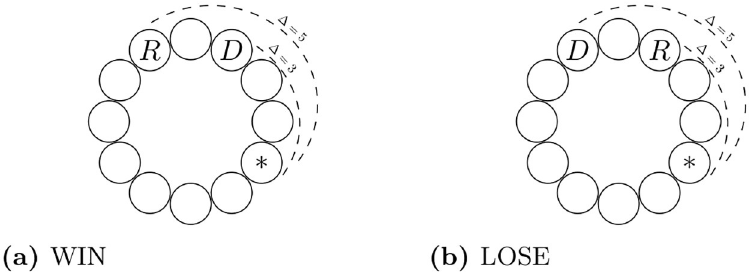
Fig 1. Role allocation procedure in treatments WIN and LOSE. Asterisk ( � ) denotes the bead randomly selected by the computer. Between the two participants, the better guess acquires the role of the dictator (D) in treatment WIN (a) and the role of the recipient (R) in treatment LOSE (b). The better guess is the one closer, in either direction, to the selected bead. There were 19 beads to choose from in the actual